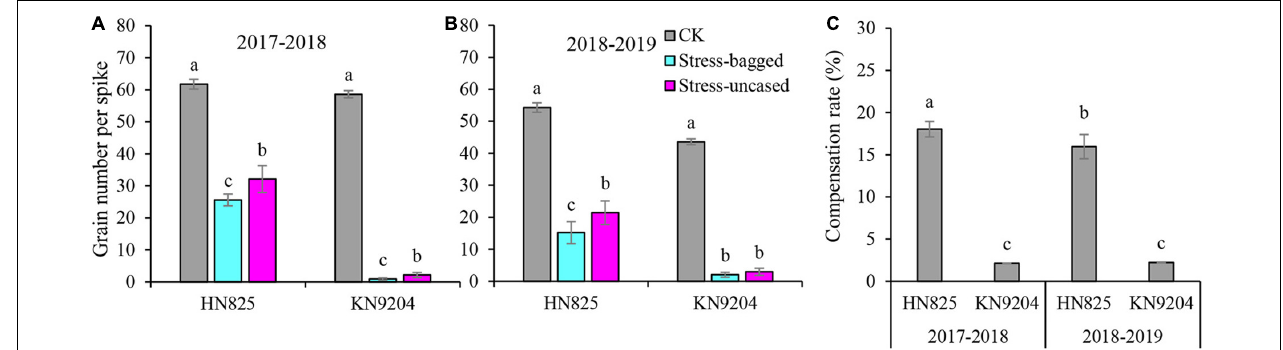
FIGURE 2 | Testing the seed setting rate of heterologous pollen pollination of spike after low light stress in 2017–2018 (A) and in 2018–2019 (B) . (C) Compensation rate of heterologous pollen pollination of the spike to grain number after low light stress. CK: grain number per spike of control plants were grown under normal light conditions; Stress-bagged: grain number per spike with white bags after removing low light stress; Stress-uncased: grain number per spike without white bags after removing low light stress; Different letters in each cultivar indicate the statistically significant differences between treatments ( P < 0.05) (A,B)